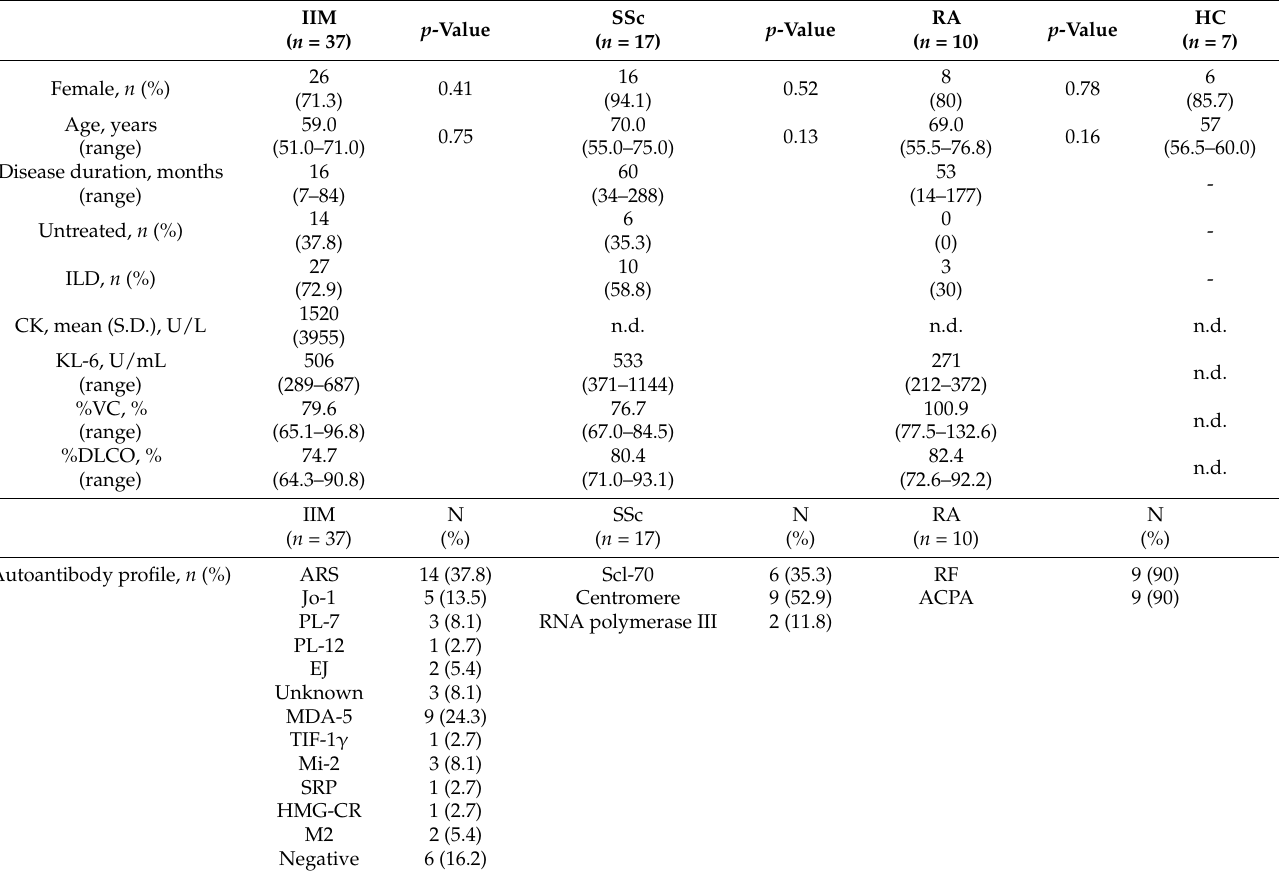
Table 1. Demographic data and baseline characteristics of patients and